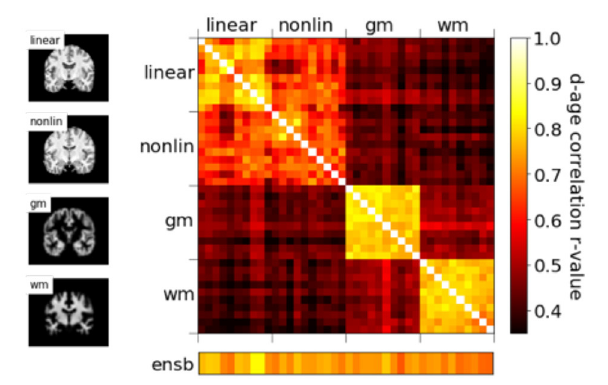
FIGURE 5 | Correlations of predicted brain age difference (d-age) between different models, showing similar results as Peng et al. (24).